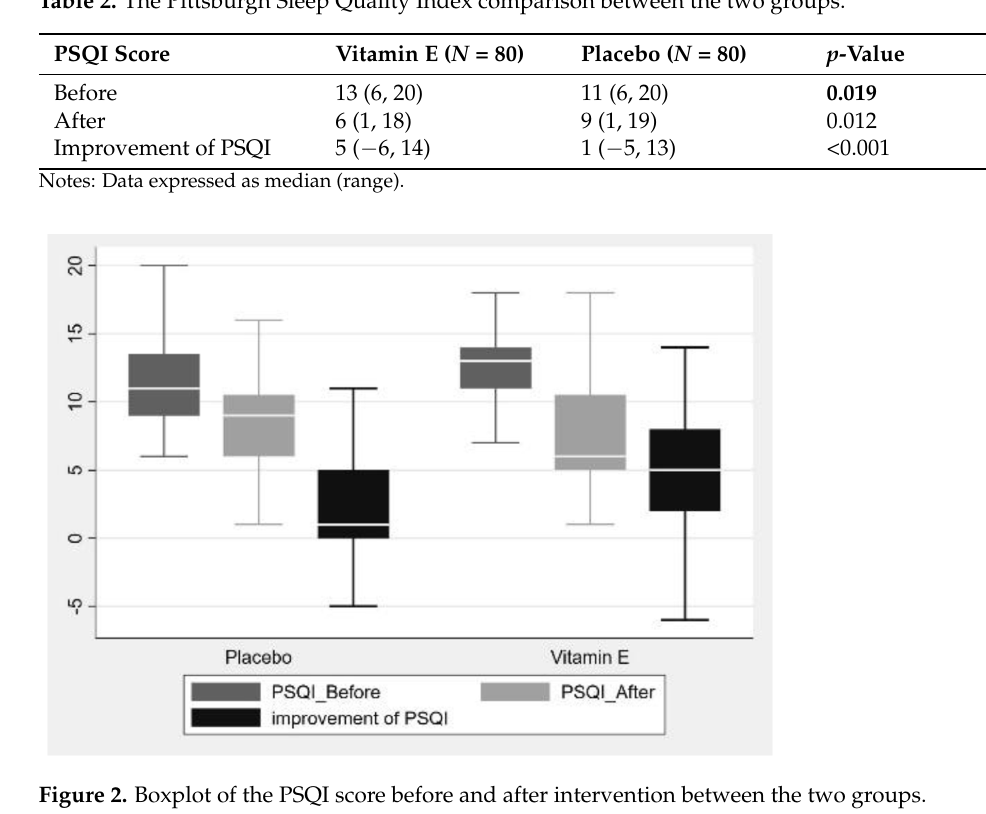
Table 2. The Pittsburgh Sleep Quality Index comparison between the two groups.